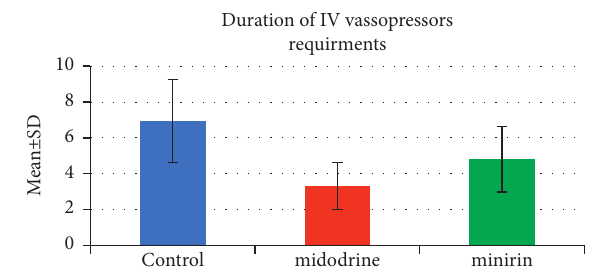
Figure 2: IV vasopressor requirements time.